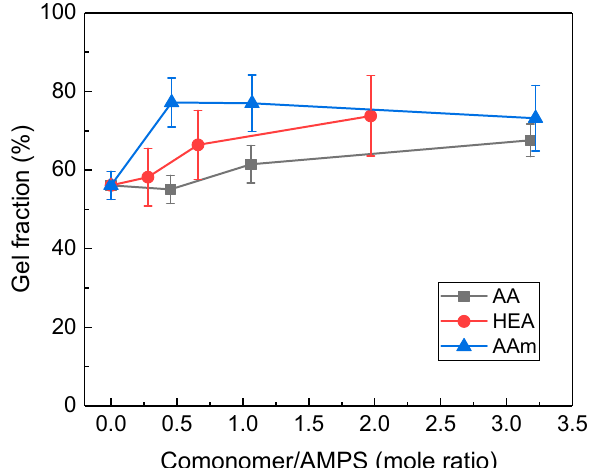
Figure 6. Gel fraction (%) of AMPS hydrogels modified with different comonomers: AA, HEA, and AAm.